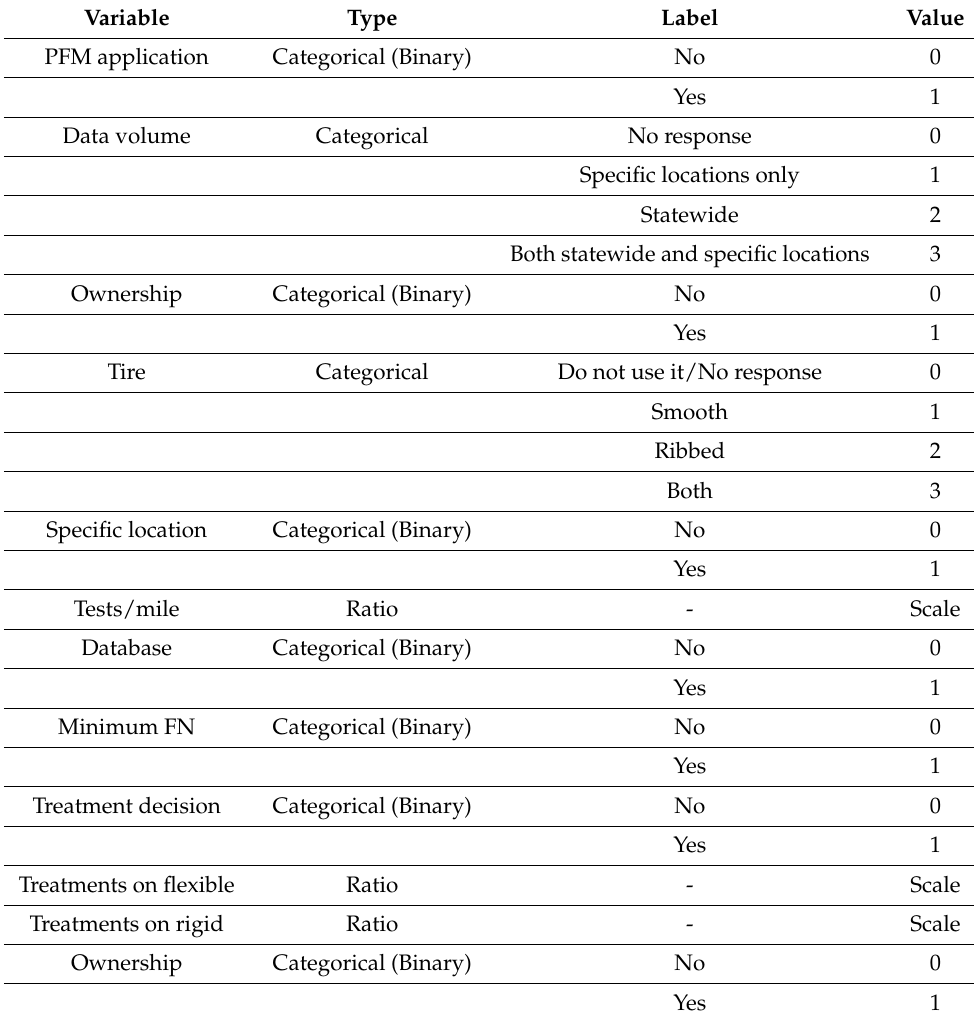
Table 2. Types of variables for the studied survey